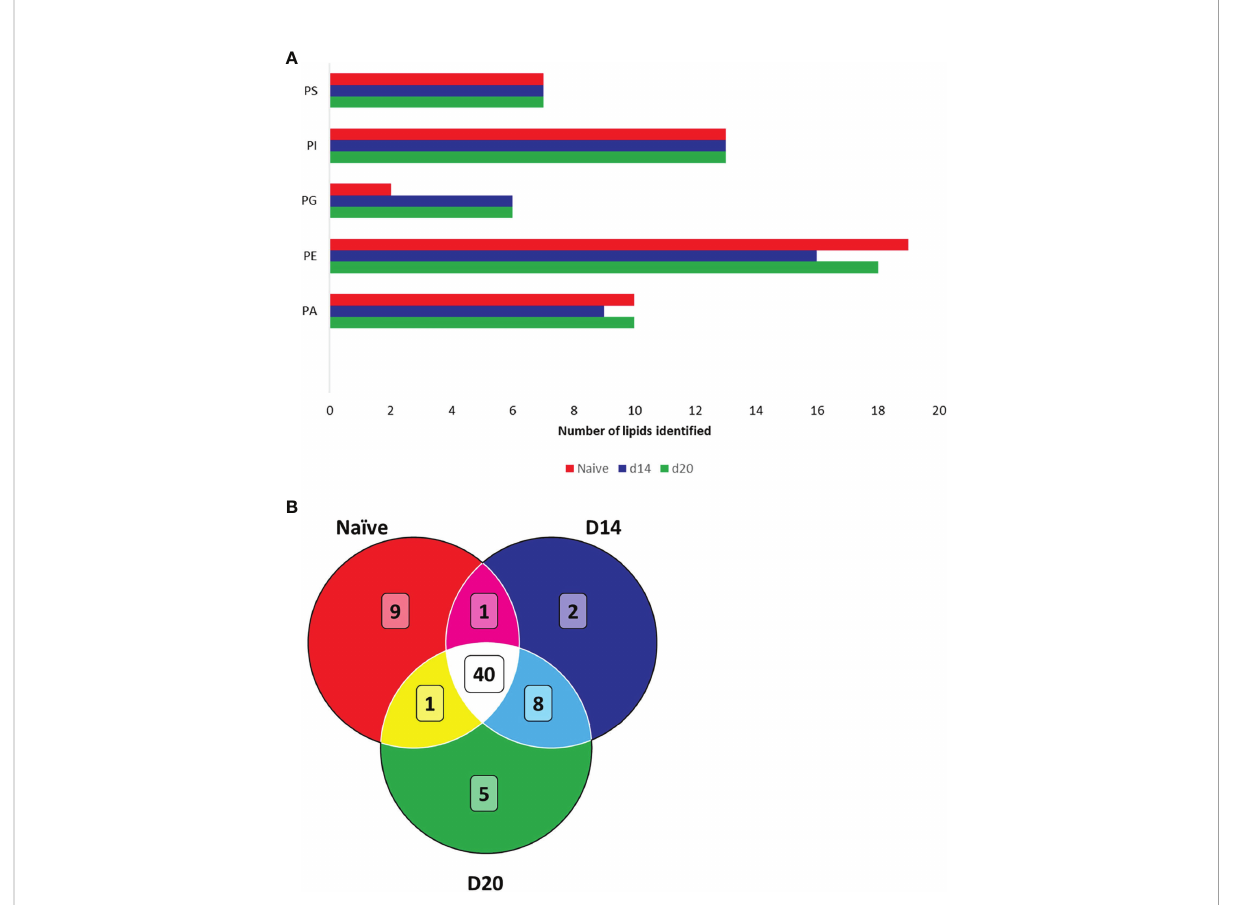
FIGURE 4 Structural identi fi cation of lipids using FTMS. (A) Lipids identi fi ed in naïve and infected mouse liver. Bar chart displays the total number of identi fi ed lipids per lipid class. (B) Venn diagram showing overlap of identi fi ed lipids in naïve and infected liver. Phosphatidic acids (PA), phosphatidylethanolamines (PE), phosphatidylinositols (PI), phosphatidylserines (PS) and phosphatidylglycerols (PG). Lipids are detailed in Table